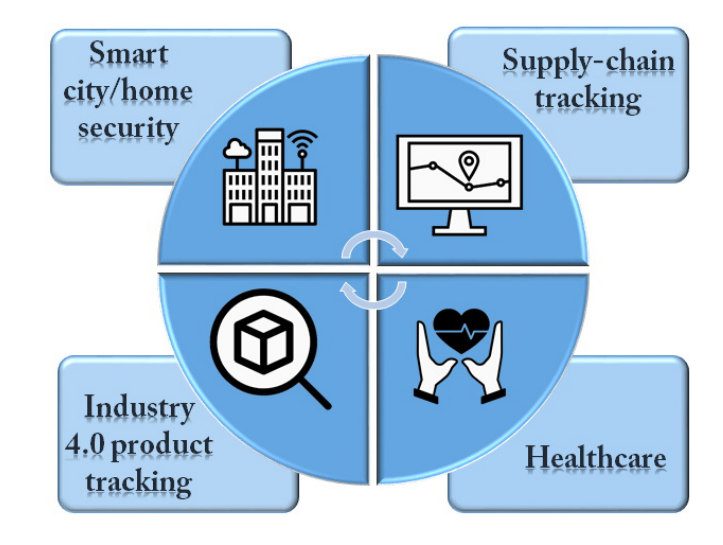
Figure 5. Blockchain and IoT main use